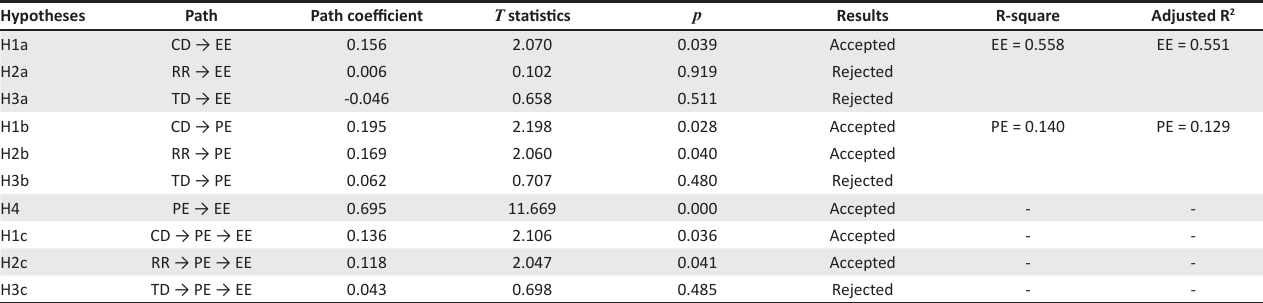
TABLE 2: Results of hypothesis testing with R 2 and adjusted R 2 .